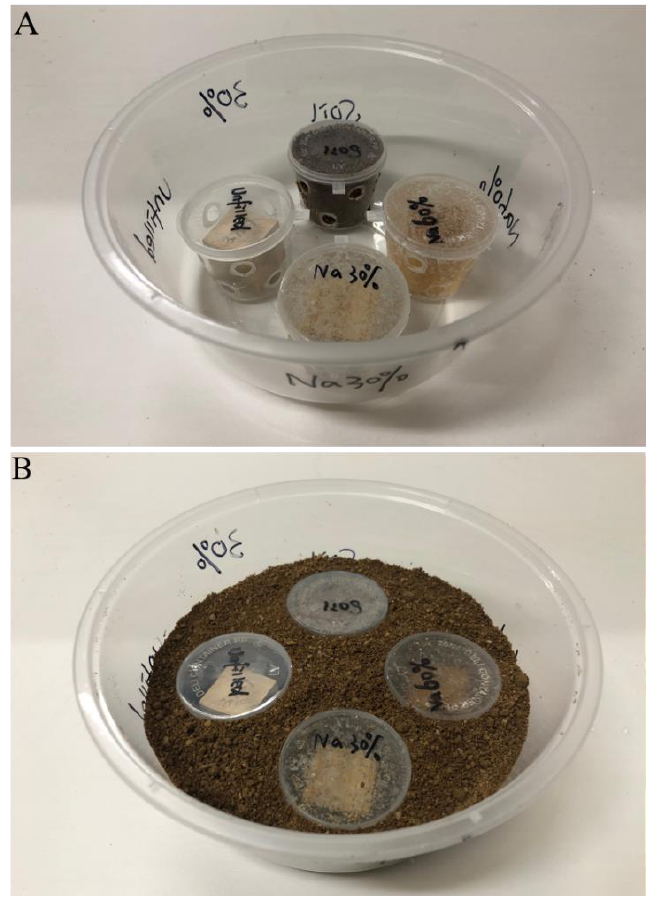
Figure 2. Experiment settings to investigate the preference of termites to super absorbent polymers filled in baiting containers. Four baiting containers (either filled with 30% or 60% water-saturated super absorbent polymers, or 30%-moisture soil, or unfilled) were placed on the bottom of the bioassay arena ( A ), and soil was used as the substrate to bury the baiting containers ( B ).